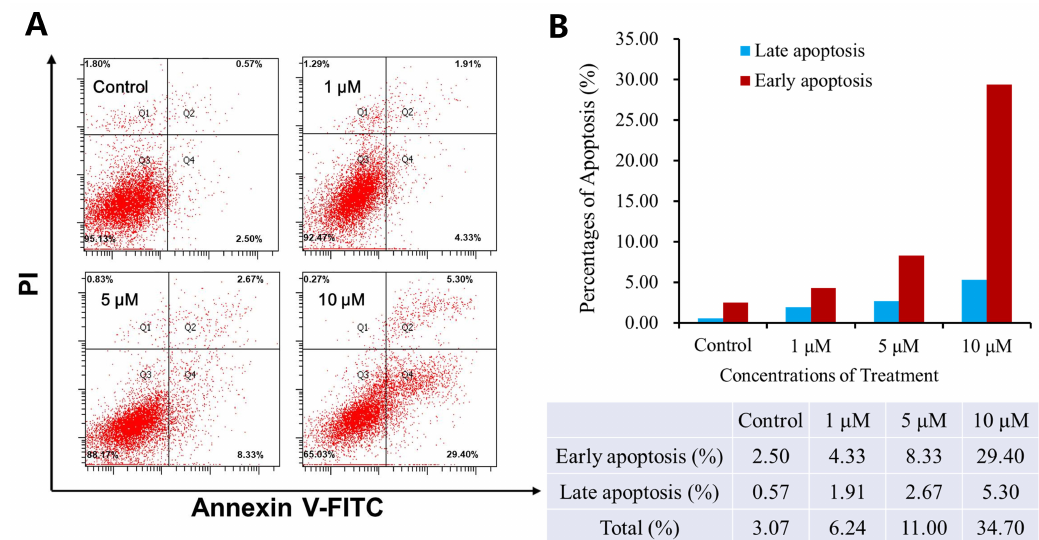
Figure 6. Compound 7i induced apoptosis of A549 cells. ( A ) Apoptosis effect on A549 cell line induced by compound 7i for 24 h using Annexin V-FITC/PI double staining and flow-cytometry calculation. The lower left quadrant represents live cells, the lower right is for early/primary apoptotic cells, upper right is for late/secondary apoptotic cells, and the upper left represents cells damaged during the procedure; ( B ) Quantitative analysis of apoptotic cells. The experiments were performed three times, and a representative experiment is shown.